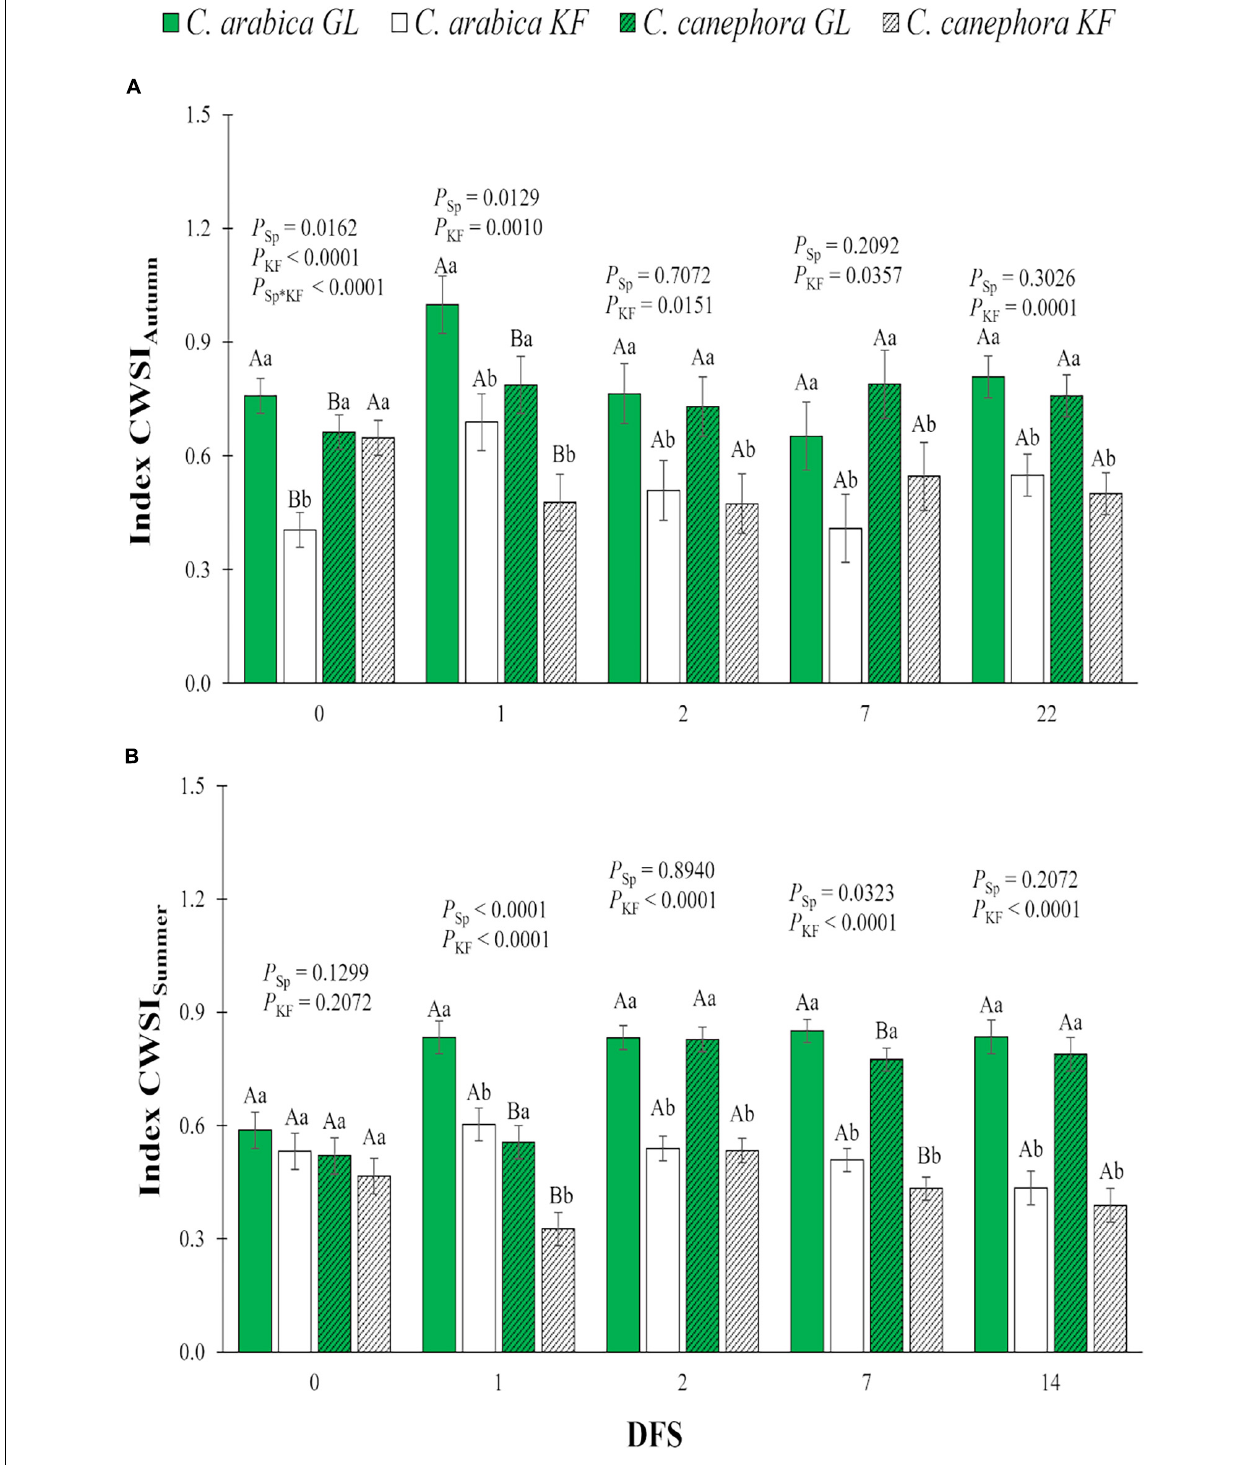
FIGURE 3 | Water stress index (CWSI) in young plants of two species (Sp.), Coffea arabica and C. canephora , protected with kaolin film (KF) and not protected (GL), during transference of coffee seedlings from the nursery to the field in (A) autumn (CWSI Autumn ) and (B) summer (CWSI Summer ). Means ± S.E. followed by different lowercase letters indicate statistically different values between kaolin treatments within the same species, while uppercase letters indicate differences between two coffee species within the same kaolin treatment, detected by the ANOVA and Tukey test ( n = 5). P -values for effects of species kaolin and their interactions are indicated for days of exposure to full sunlight